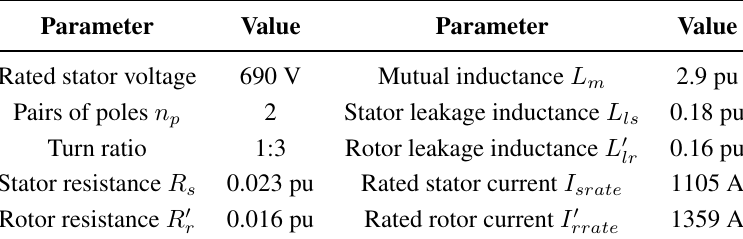
Table 1. Electric parameters of a 1.5 MW DFIG.